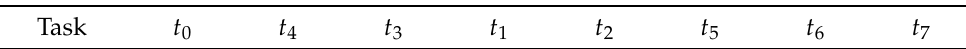
Table 4. Tasks order of execution.